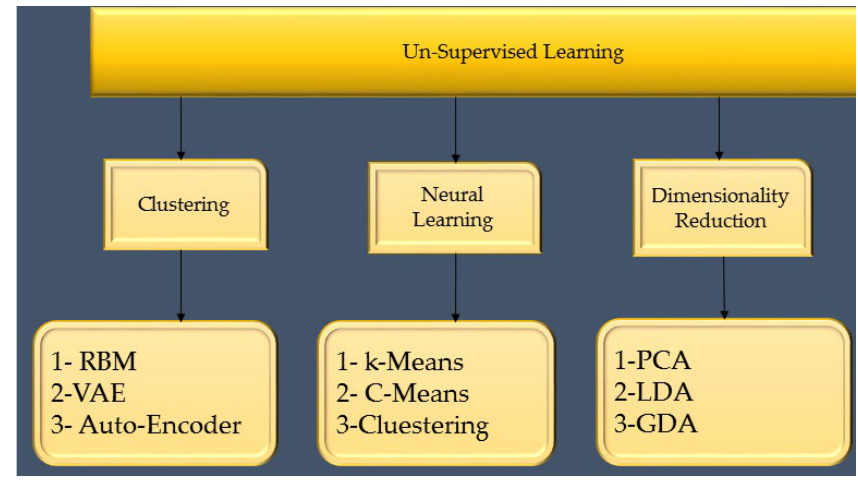
Figure 9. UN Supervised learning techniques in the smart grid.